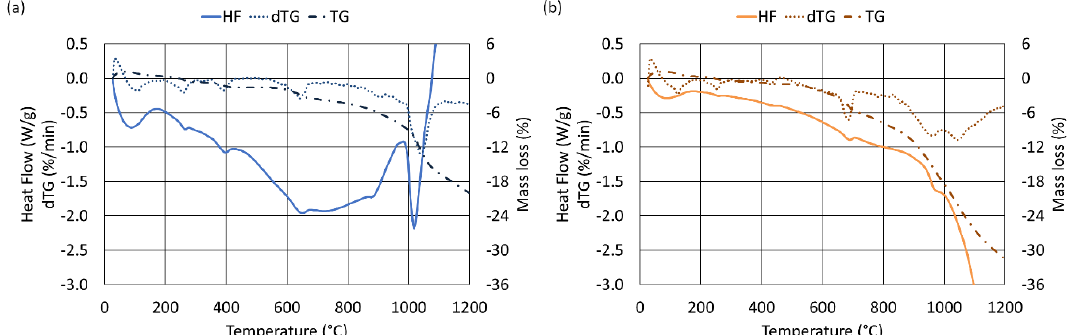
Figure 1. Example of heat flow, thermogravimetry (TG) and first order derivate of thermogravimetry (dTG) curves for the sample with pure graphite (sample C2—0.85 C / Fe 2 O 3 ) ( a ) and with blast furnace sludges (sample A3—1.18 C / Fe 2 O 3 ) as reducing agent ( b ), argon atmosphere. Full line: heat flow; dash-dot line: TG; dotted line: dTG.